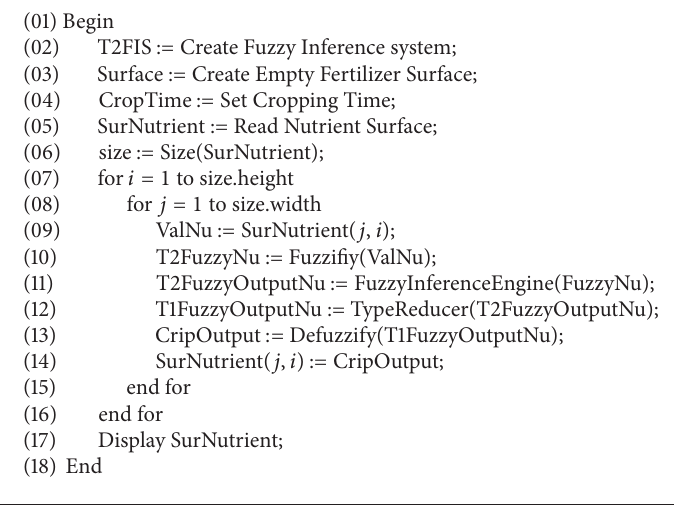
Algorithm 1: Algorithm for fuzzy decision support system for fertilizer.